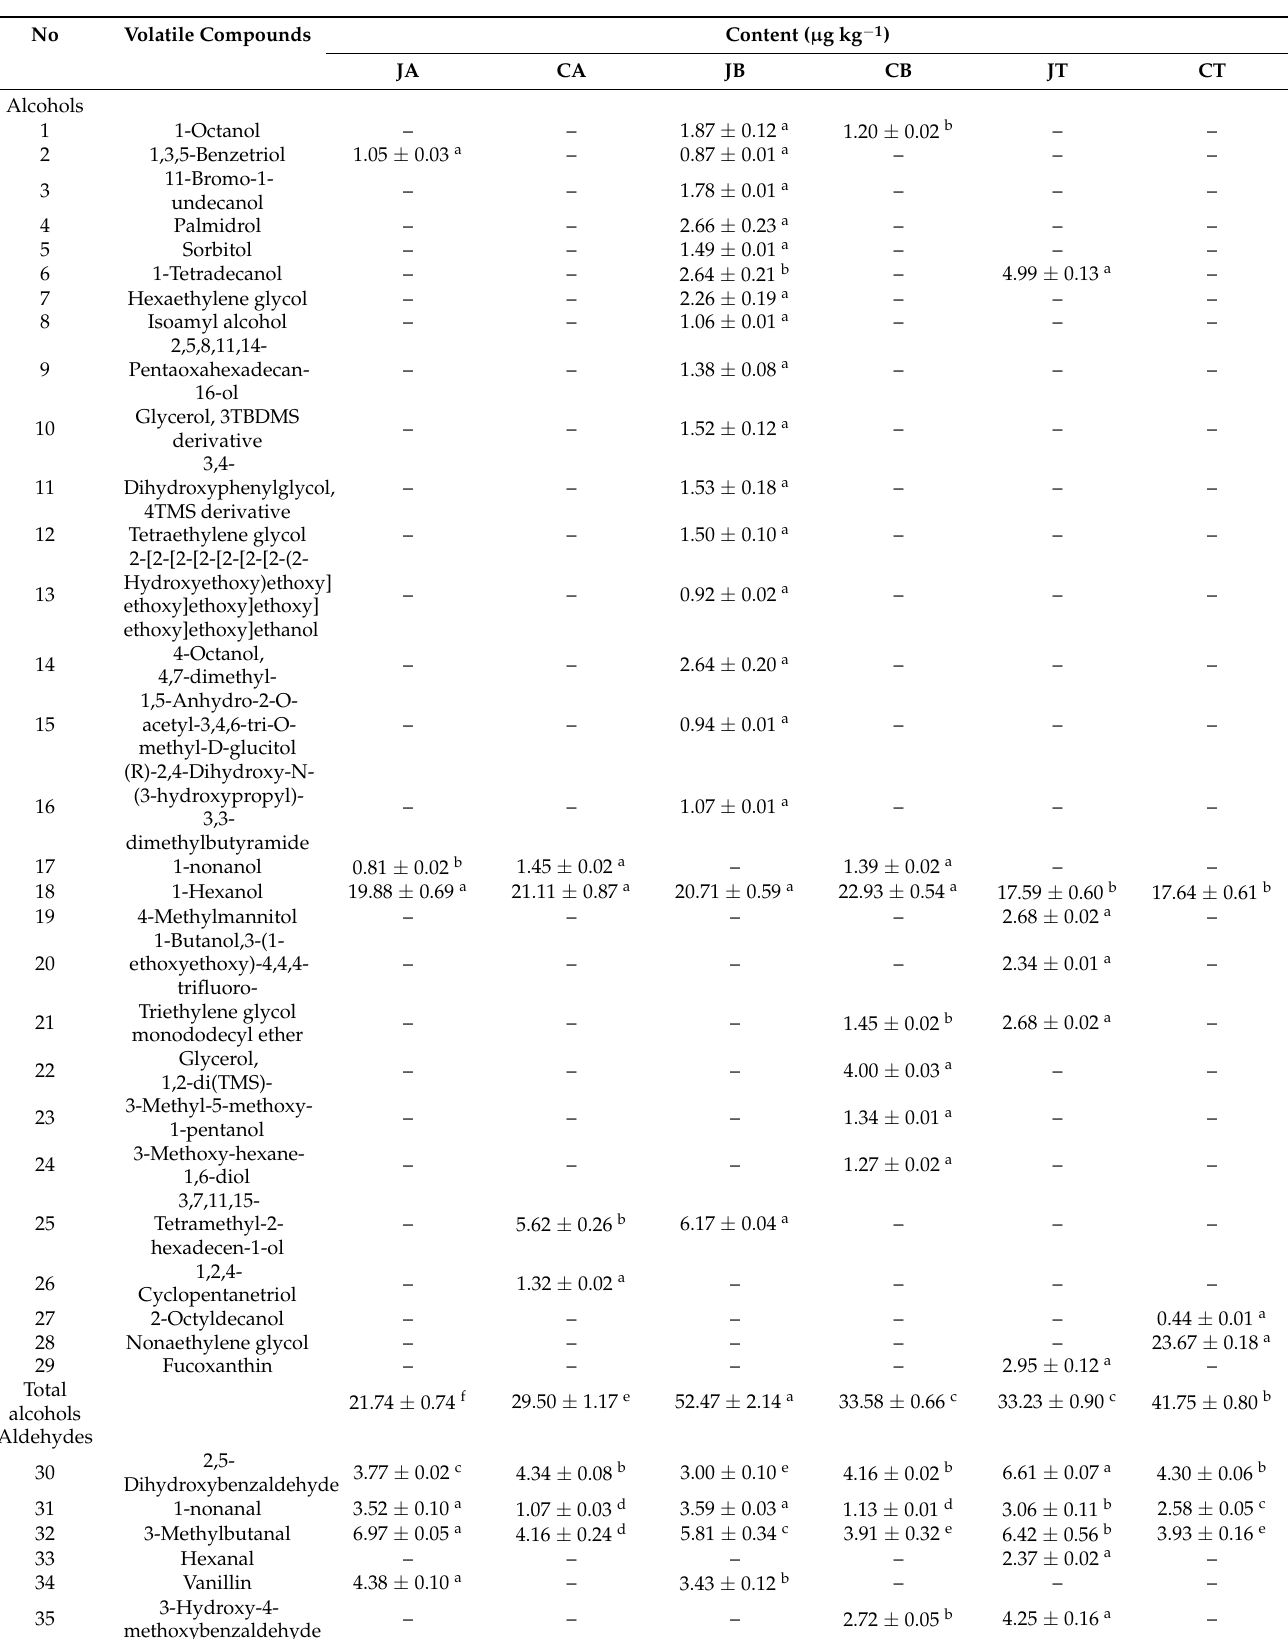
Table 2. Contents ( µ g/kg) of volatile compounds in different parts of JPGC and